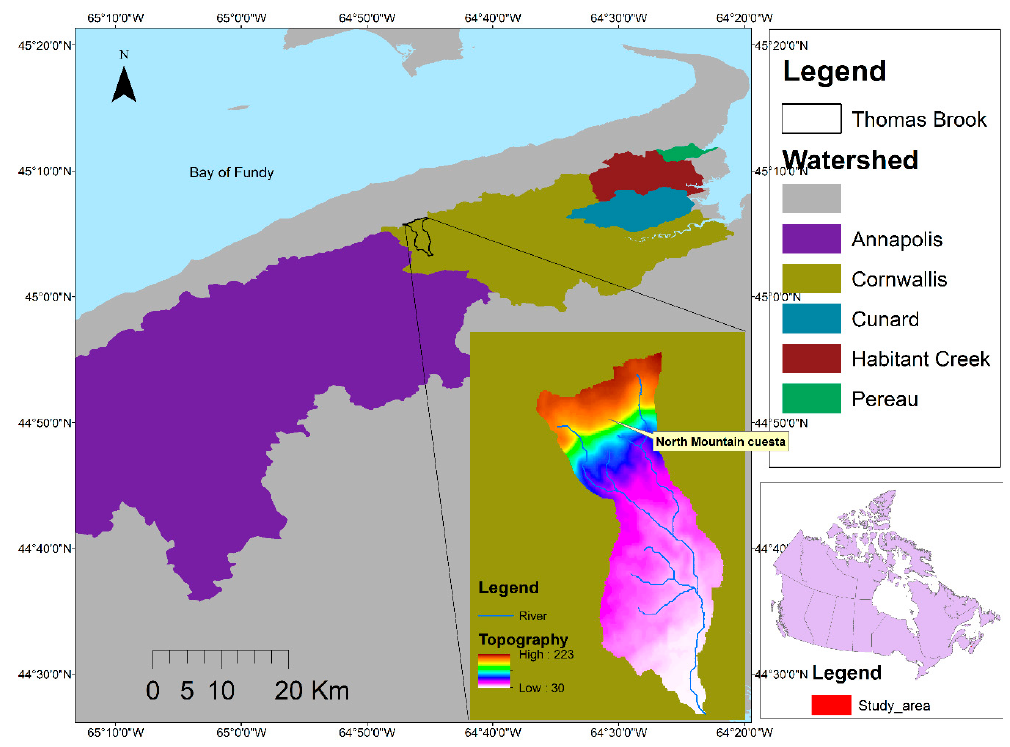
Figure 1. Location of Thomas Brook catchment in Annapolis Valley, Nova Scotia, Canada [17].